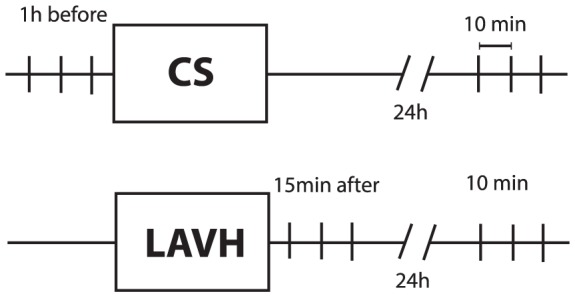
Study design for the CS group and the LAVH-group.Each vertical line stands for a single measurement. CS: caesarean section; LAVH: laparoscopic assisted vaginal hysterectomy.